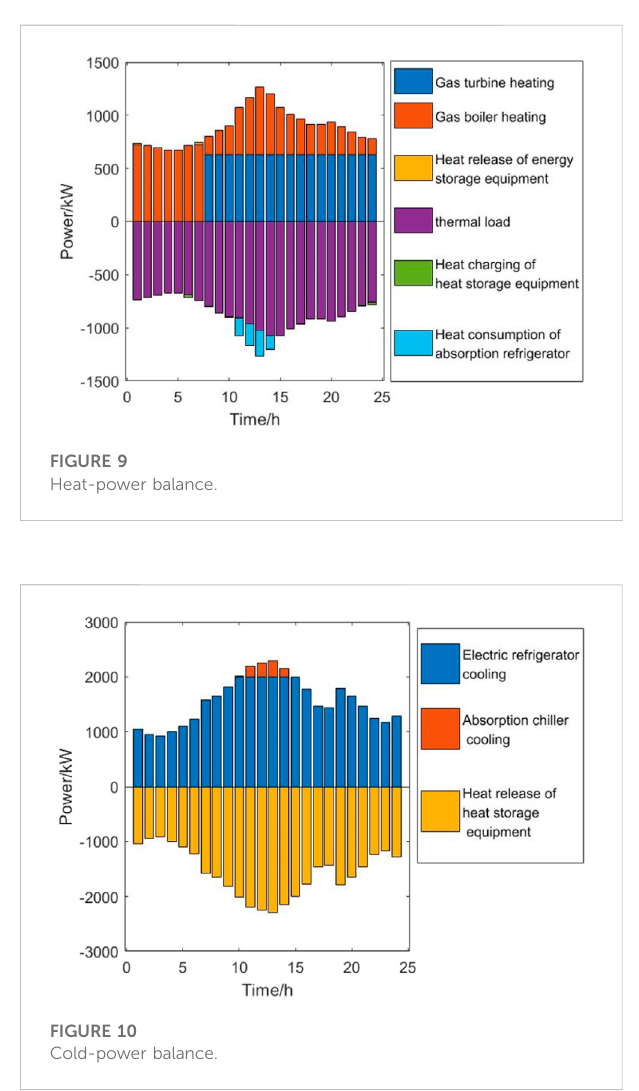
FIGURE 10 Cold-power